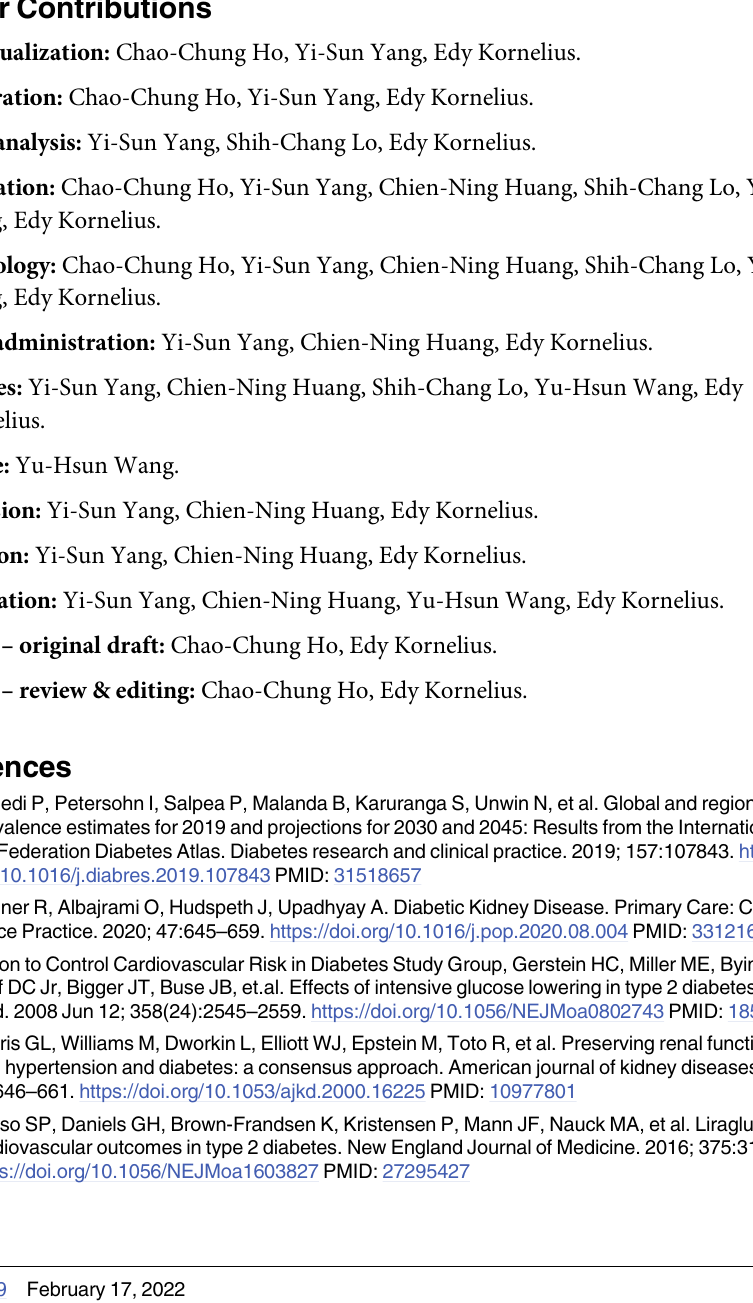
S2 Table. The occurrence of regression of UACR between Pioglitazone and non-Pioglita- zone